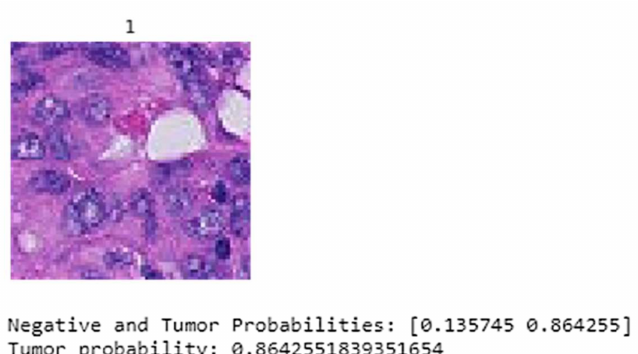
Figure 15. Results after applying the test time augmentation (TTA).